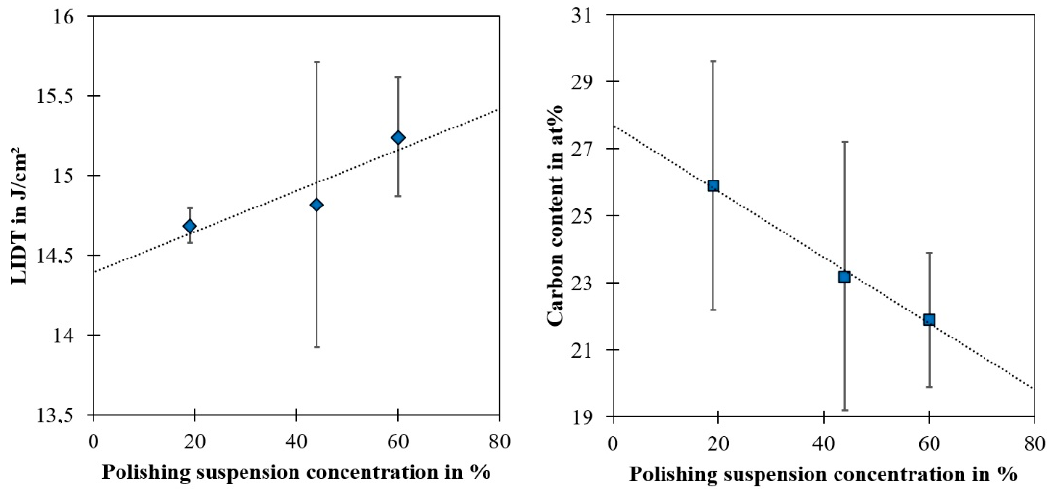
Figure 4. Laser-induced damage threshold (LIDT, left ) and carbon content ( right ) vs. polishing suspension concentration including trend (dotted